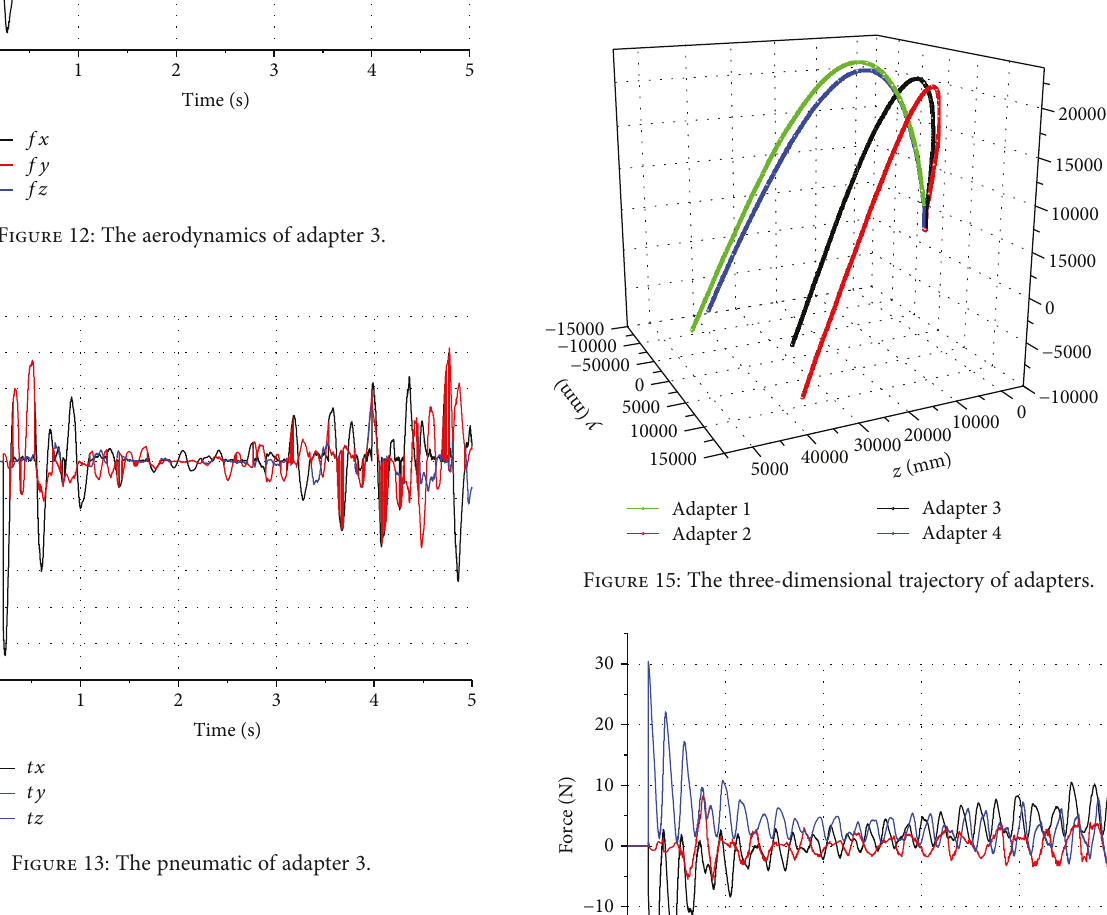
Figure 14: The diagram of adapters ’ placement.